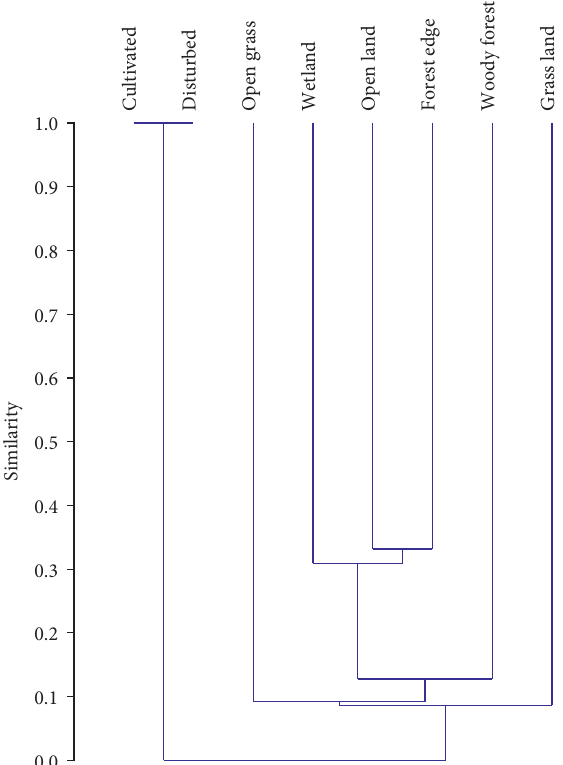
Figure 9: Single linkage cluster analysis between habitat types based on Bray–Curtis similarity (short forms denote the following: cultivated stands for cultivated land, disturbed for disturbed land, and open grass for open grassland habitats).